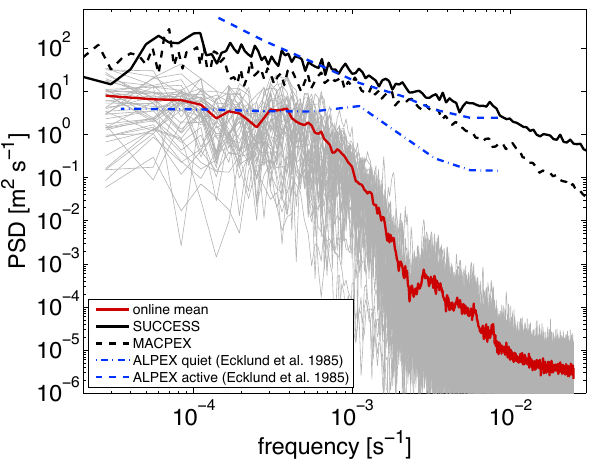
Figure 4. Power spectral density (PSD) of the vertical wind calcu- lated from online trajectories (grey) passing above Jungfraujoch at 09:00UTC between 10.0 and 11.5km. Red curve: average of online trajectories. Solid and dashed black lines: PSDs of vertical veloci- ties measured during SUCCESS (Toon et al., 1998) and MACPEX (Rollins et al., 2014), respectively. Blue dashed and dashed-dotted lines: data from the ALPEX campaign for active and quiet days, respectively (Kuettner,